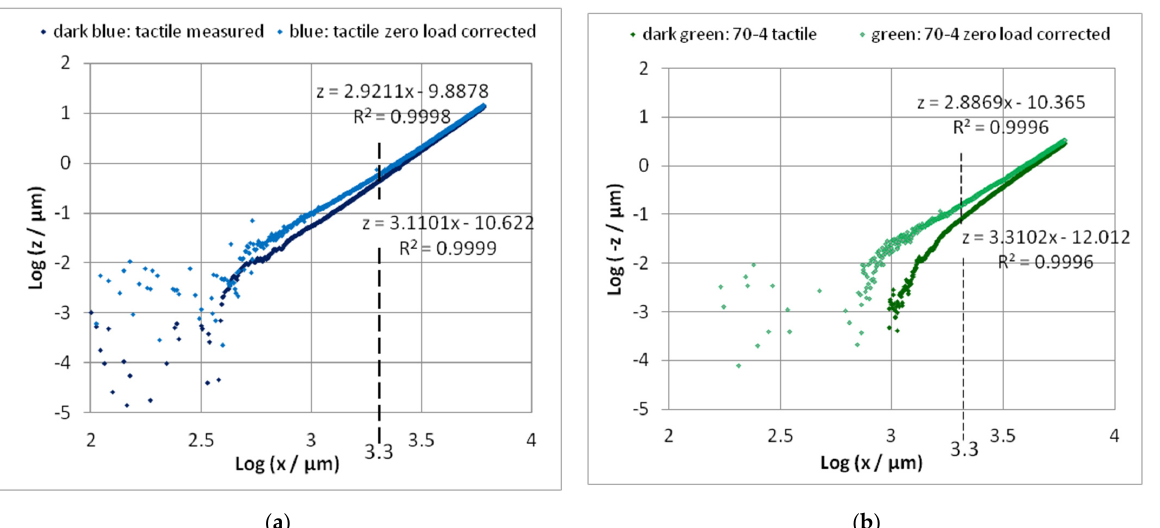
Figure 15. The dependence of the zero load z 0 E on the thickness measured in the direction “cross”, (black line, values bow corrected, Table 5) and “long” (red line, single-end leveled and bow cor- rected). The values for the thicknesses h = 30 μ m are mean values of 4 cantilevers.